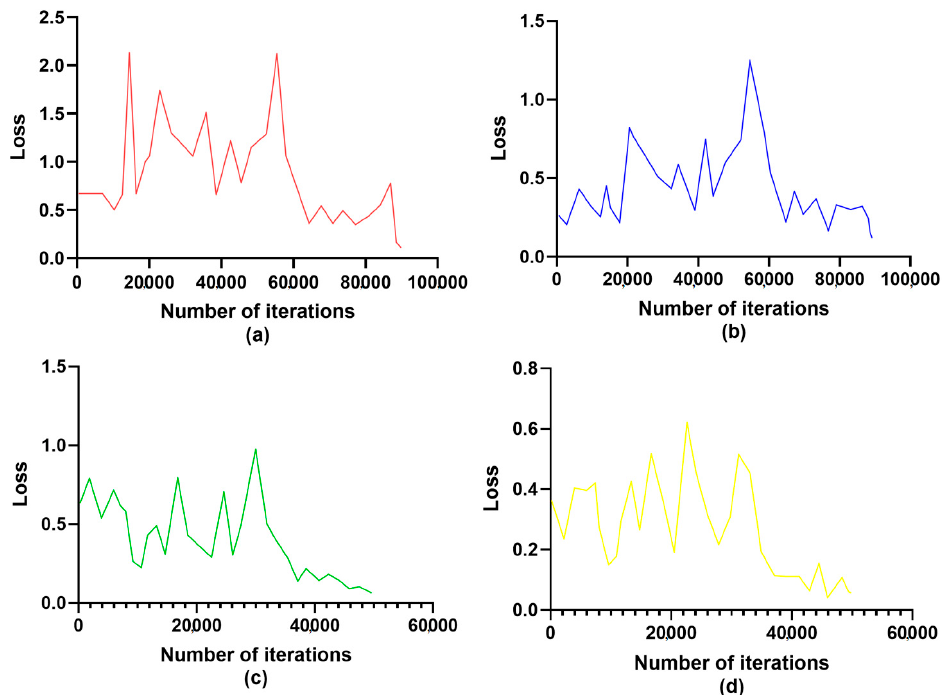
Figure 8. Loss curves of four training stages of the model ( a – d ), representing YOLOv3-416, YOLOv3-tiny-416, UW_YOLOv3-416, and UW_YOLOv3-224, respectively.